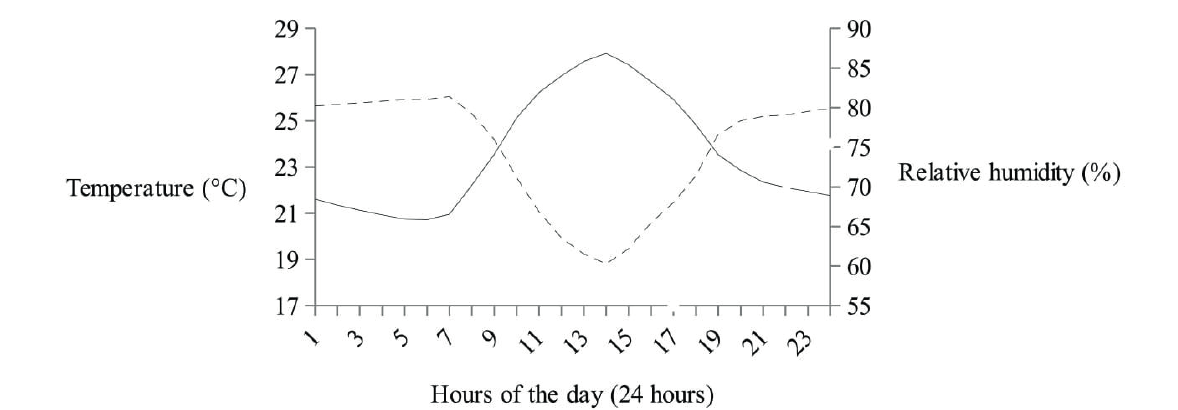
Figure 1 - Temperature (continuous line) and relative humidity of the air (dashed line) verified in the maternity